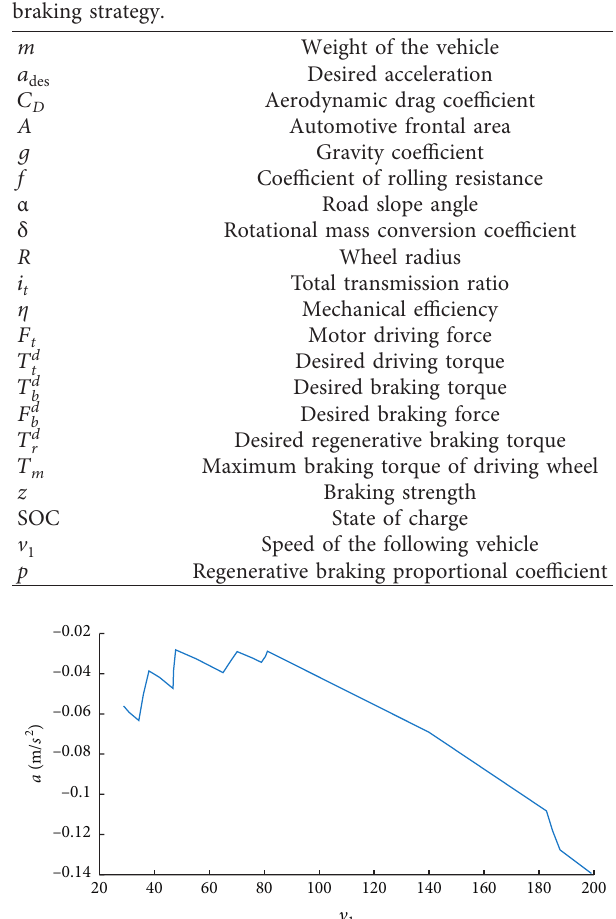
Figure 2: Ground deceleration of the following vehicle in a range of normal driving speed.